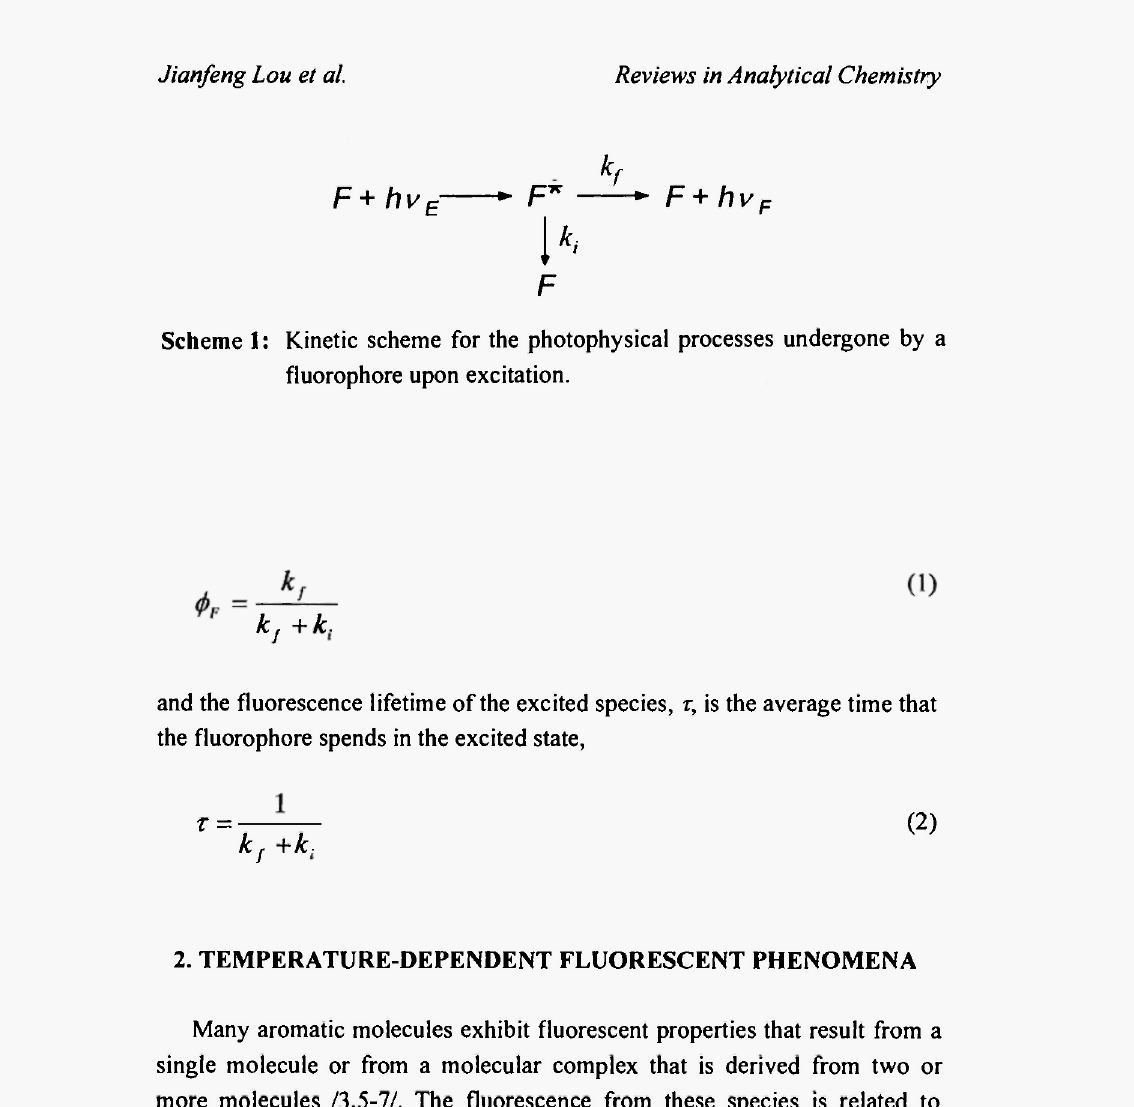
Scheme 1 : Kinetic scheme for the photophysical processes undergone by a fluorophore upon